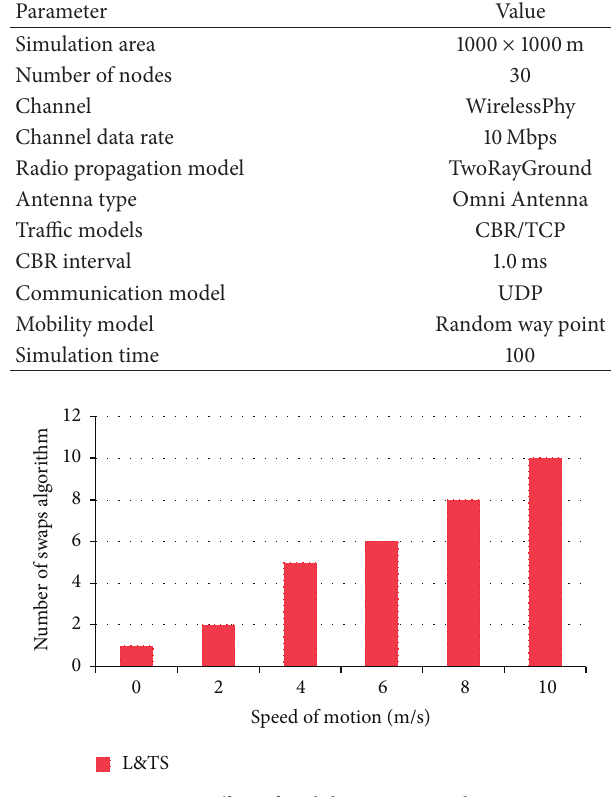
Figure 10: Effect of mobility in L&TS scheme.